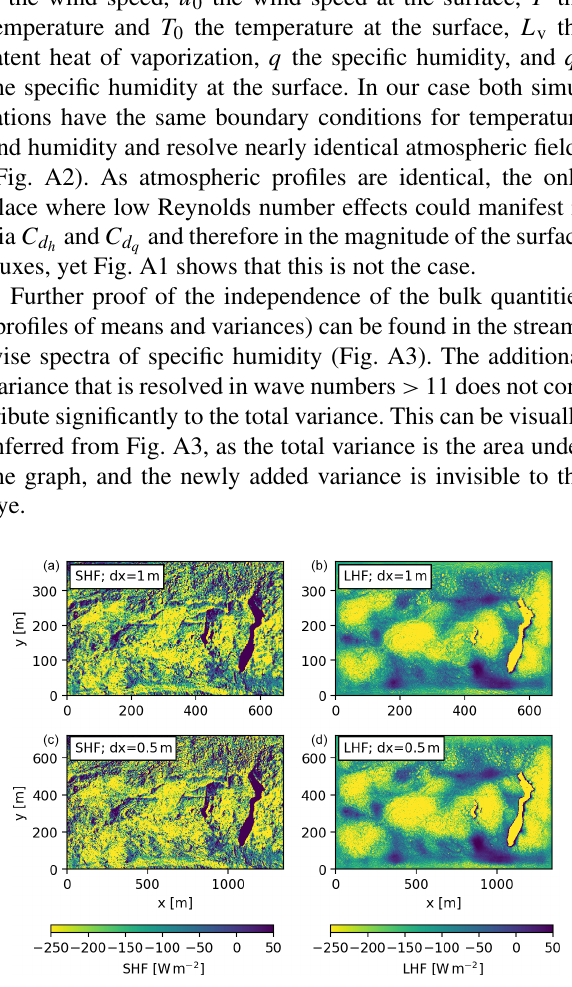
Figure A1. The averaged sensible (a, c) and latent heat flux (b, d) for the real experiment with a viscosity of 0.2m 2 s − 1 (d x = 1m; a ,b ) and with viscosity of 0.11m 2 s − 1 (d x = 0.5m; c, d ).